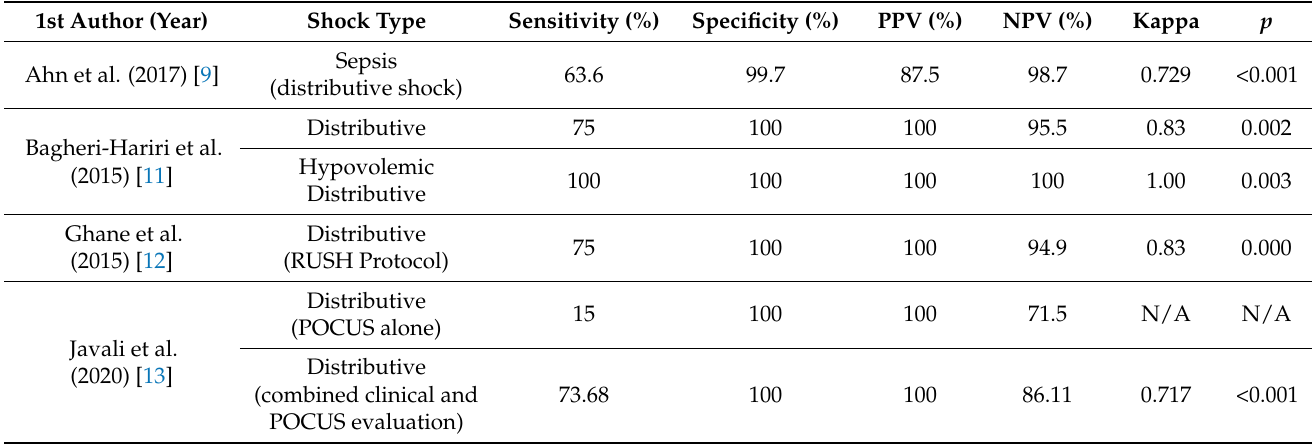
Table 4. Reliability indices (Sensitivity, Specificity, Positive and Negative Predictive Value) and Kappa coefficient showing degree of agreement between initial diagnosis (based on combined clinical and POCUS evaluation) and final diagnosis of distributive/septic